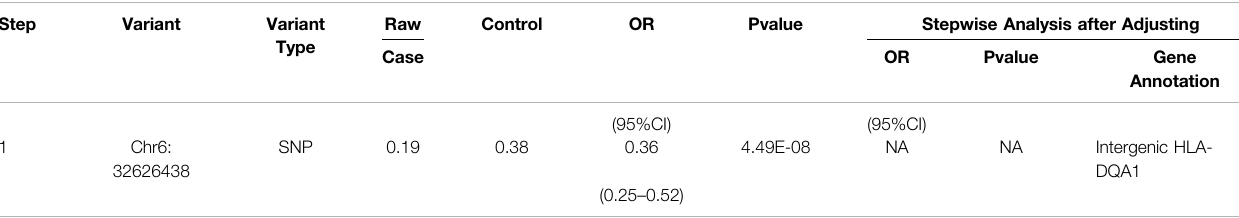
TABLE 2 | Results of stepwise conditional regression analysis of M-SM disease.